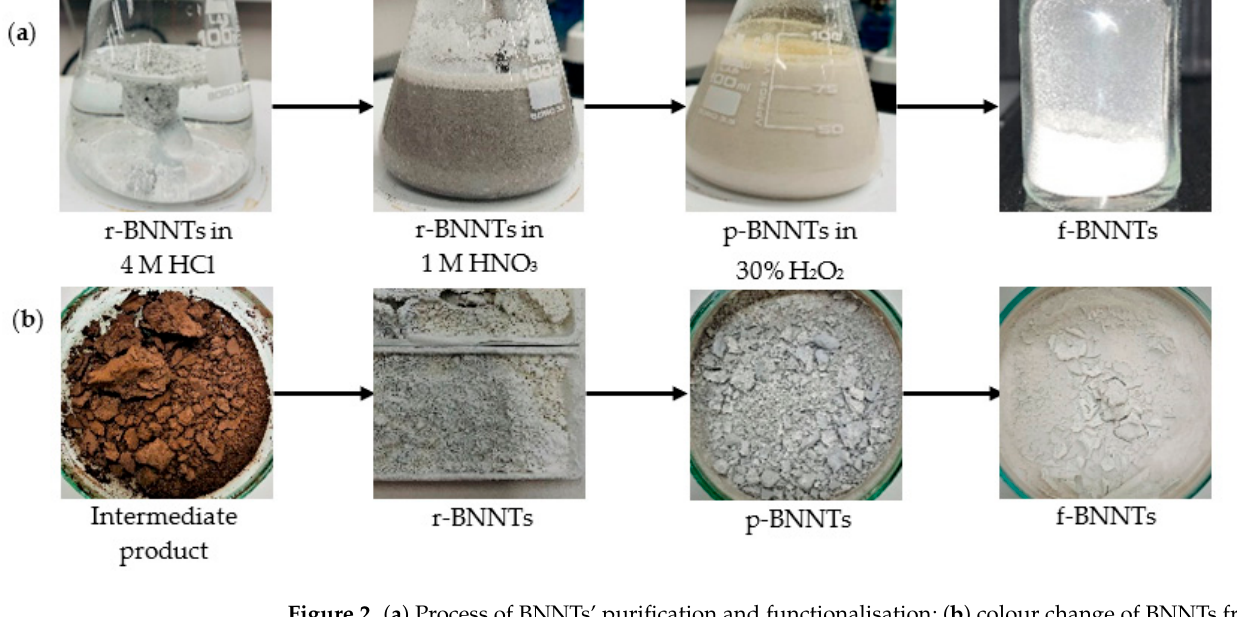
Figure 2. ( a ) Process of BNNTs’ purification and functionalisation; ( b ) colour change of BNNTs from intermediate to final stage.